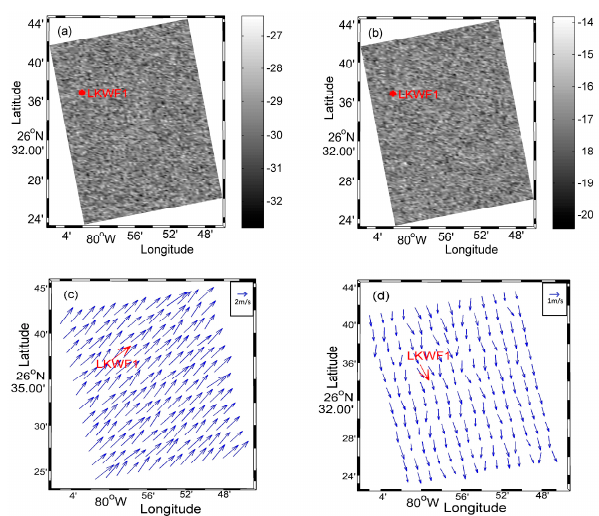
Figure 7. RADARSAT-2 SAR image in the North Atlantic, off Florida, at 02:12:56 on 19 January 2013, collocated with NDBC buoy LKWF1 showing: ( a ) VH polarization; ( b ) VV polarization; ( c ) SAR-derived wind fields; and ( d ) DWF wind fields.